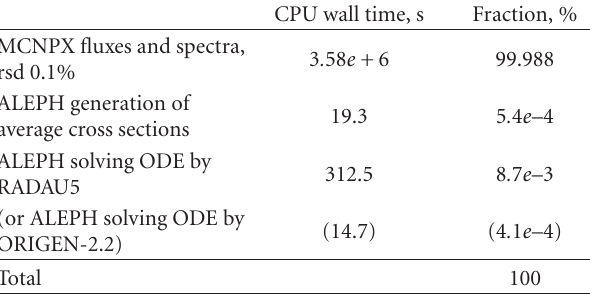
Table 3: CPU time share between ALEPH modules to calculate one irradiation step (90 days) of MYRRHA subcritical core. The MCNP(X) calculations have been performed on 64 CPU cluster using Open MPI. The number of irradiated materials is 11 (so that the reaction rates generator and the RADAU5 solver were called 11 times). Full matrix for N = 3851 nuclides is